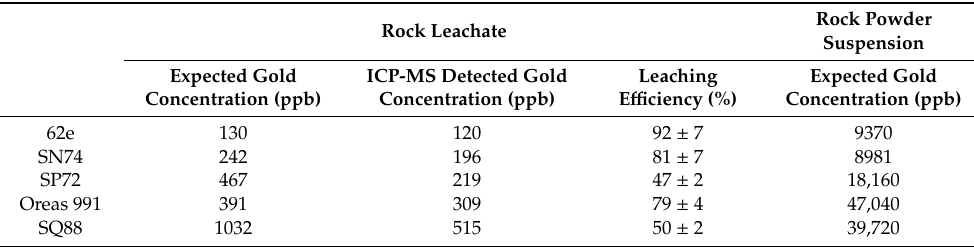
Table 3. Expected gold concentration in rock leachates (for complete leaching) and rock suspensions according to the gold content provided by rock sample supplier and dilution used. ICP-MS detected gold concentration in rock leachates.